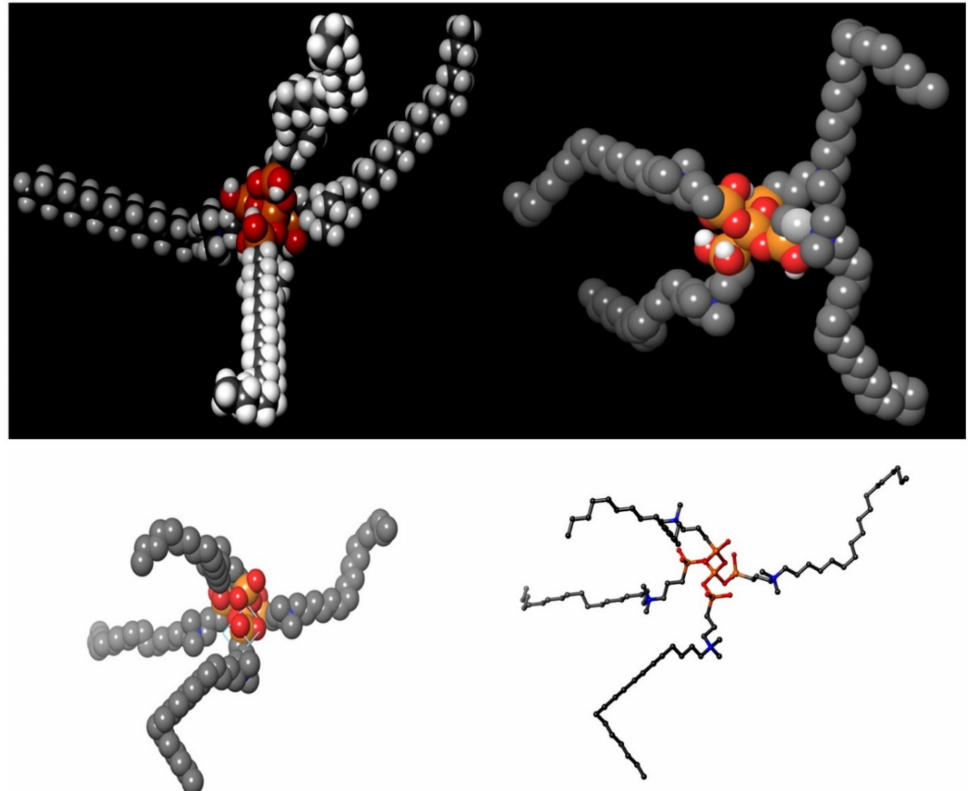
Figure 2. Proposed chemical formula of the quaternary ammonium molecule k21. Our formulation is based on organosilicon quaternary ammonium, 3-(trimethoxysilyl)-propyldimethy-octadecyl ammo- nium. It contains a long lipophilic C18 alkyl chain arm that has the ability to penetrate membranes causing cell death by direct contact and leaching of intracellular